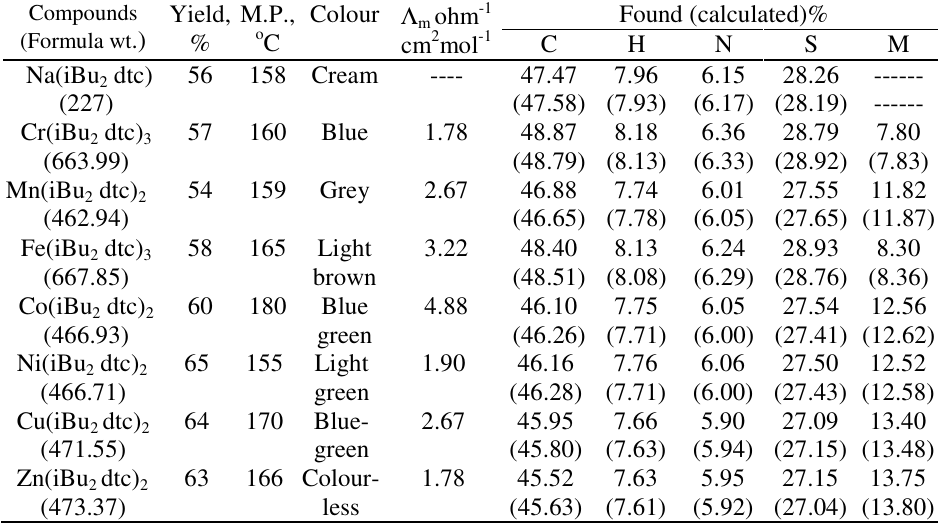
Found (calculated)% Compounds